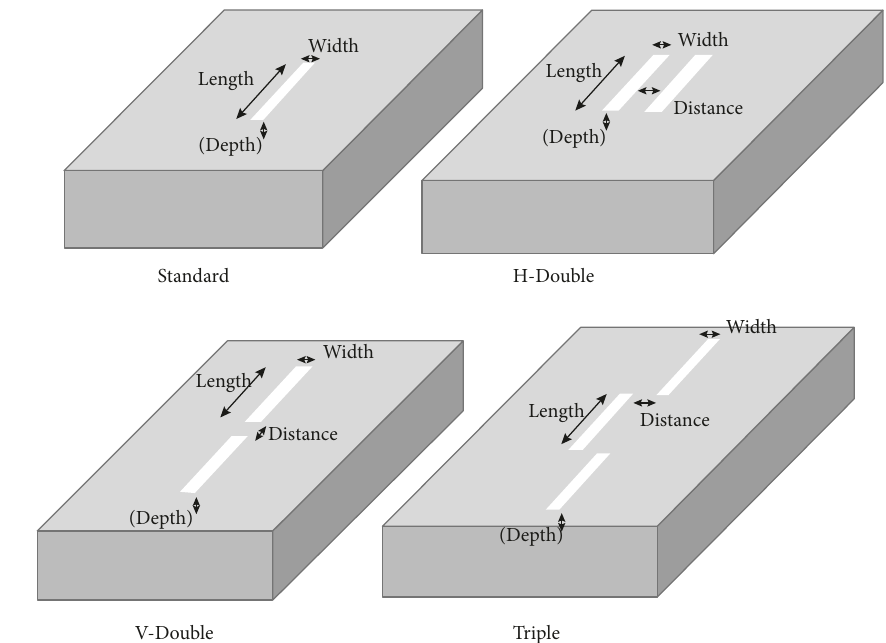
Figure 4: Types of cracks in brake disc specimens.